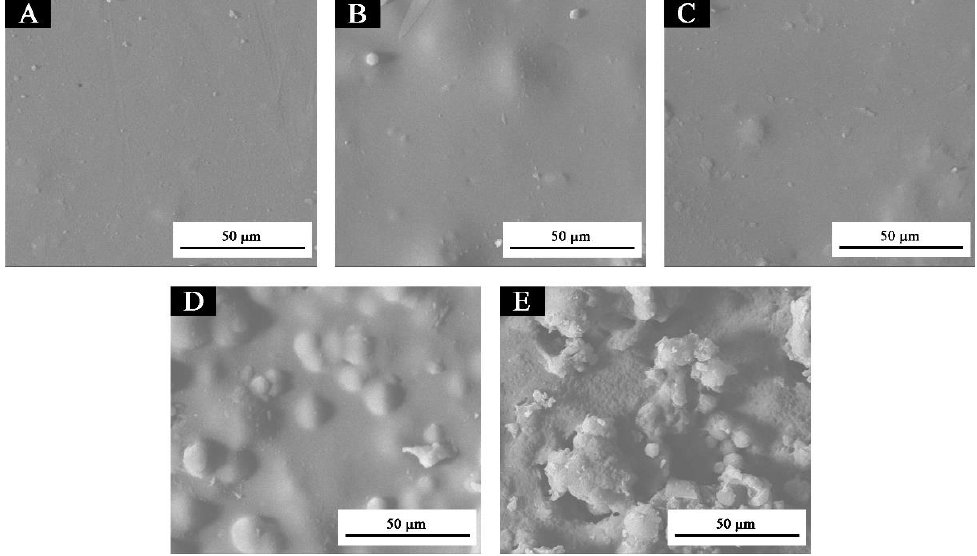
Figure 6. Effect of microcapsule concentration (0.42:1, 0.67:1, and 0.75:1 core-wall ratios) on impact resistance.